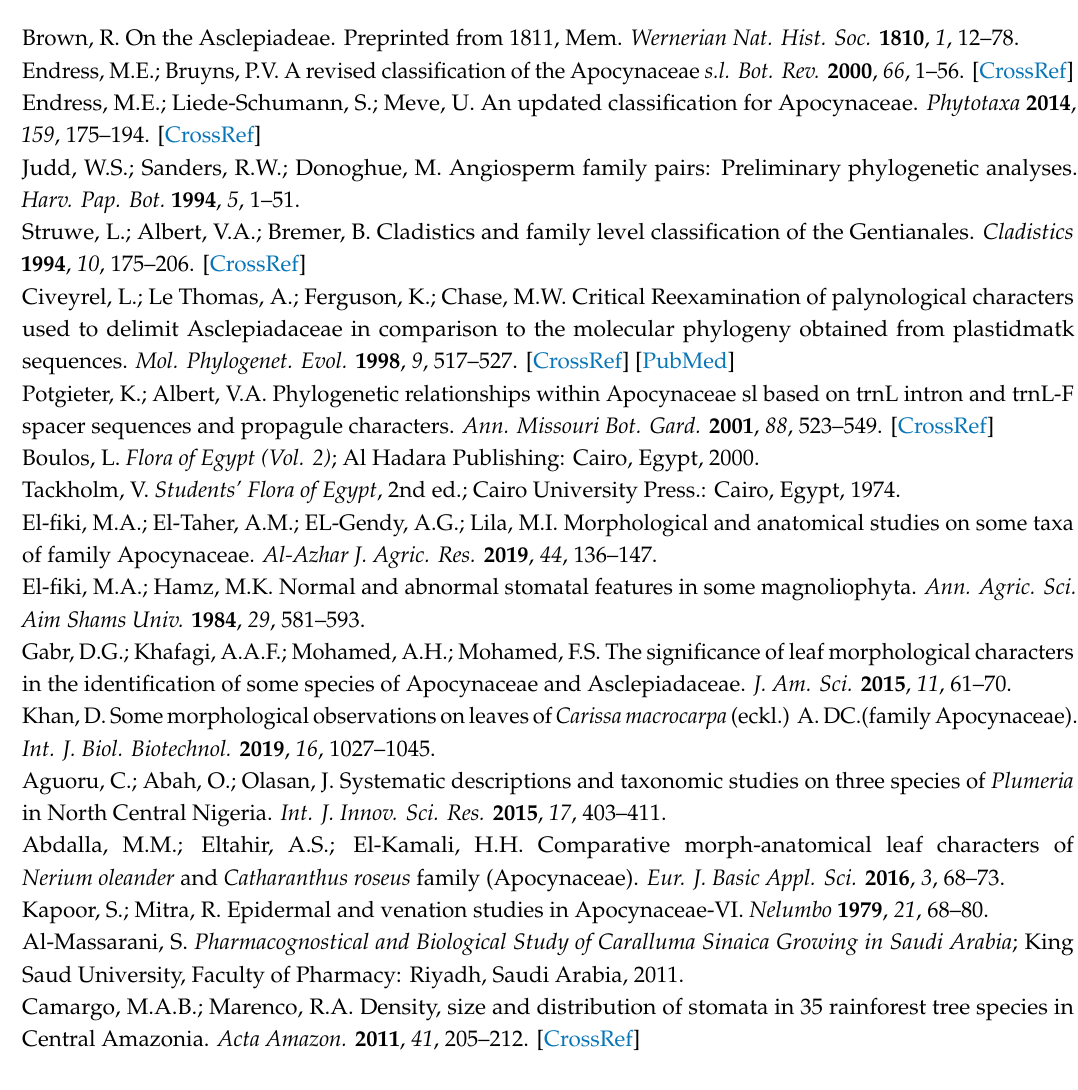
Figure S1: Leaf morphology of the studied Apocynaceae plants, Table S1: List of di ff erent characters of the eight studied Apocynaceae plants, Table S2: Correlations between variables and factor loadings of